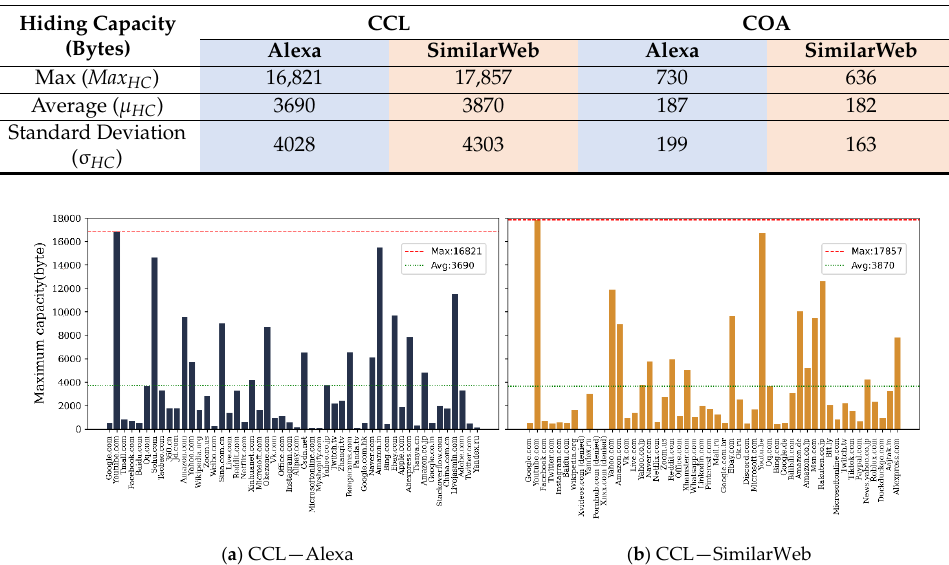
Table 2. The average and max hiding capacity measured for top websites when Changing the Case of Letters (CCL) in tags and attributes and Changing the Order of Attributes (COA) are used.